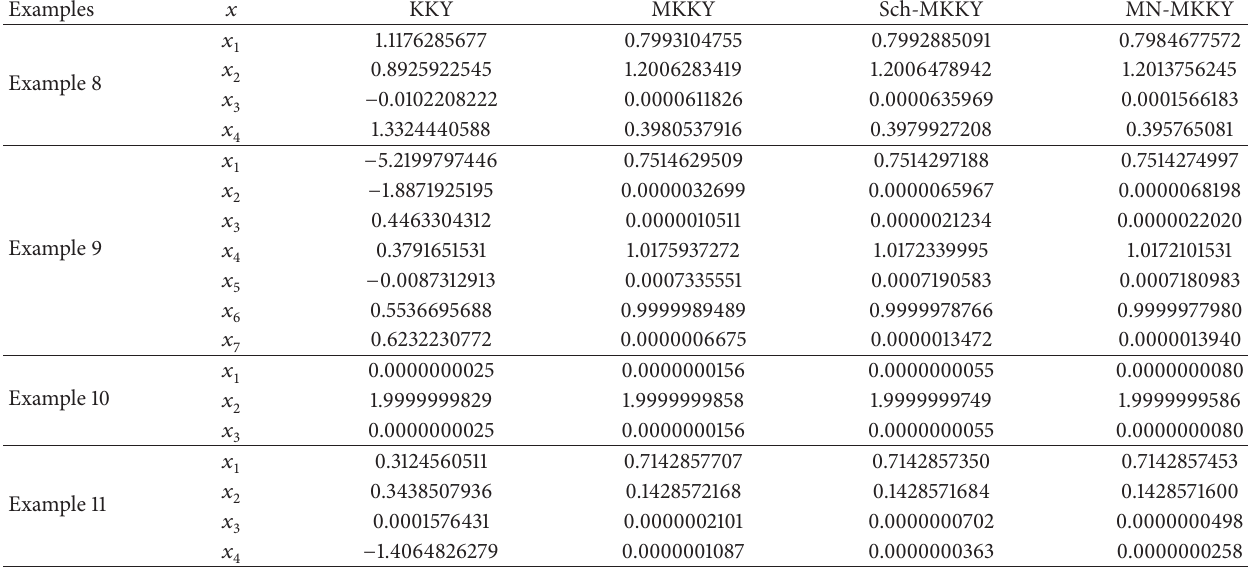
Table 1: Computed solutions using four different algorithms for Examples 8, 9, 10, and 11.